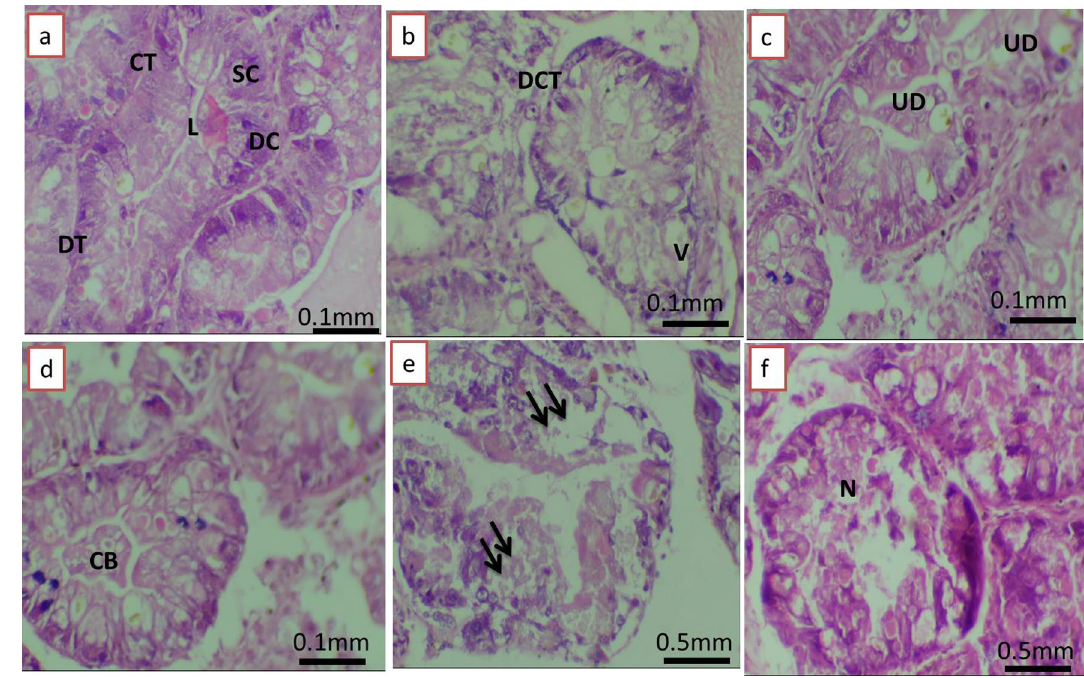
Fig. 5 Light micrographs showing the effect RIPEX 48% EC on digestive glands of Biomphalaria alexandrina . a Control, digestive tubule (DT), digestive cell (DC.), secretory cell (SC), lumen (L). b – d Snails exposed to 8 µL/L showing the presence of cellular blebs (CB), vacuolation (V) and undigested food (UD). e , f : Snails exposed to 16 µL/L showing tissue degeneration (arrows) and necrosis